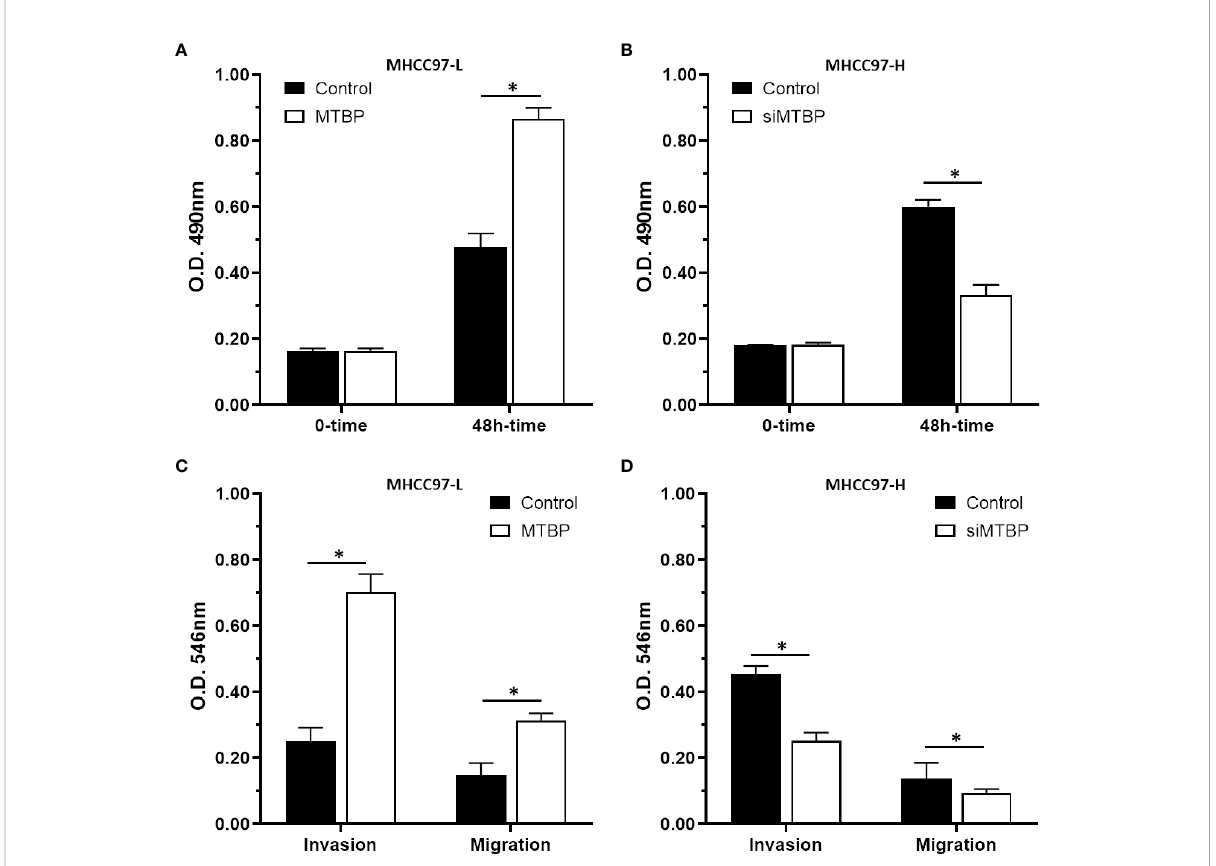
FIGURE 8 MTBP promotes the in vitro proliferation, invasion or migration of HCC cells. (A – C) MHCC97-L cells were transfected with control or MTBP expression vectors, and (B – D) MHCC97-H cells were transfected with control or siMTBP. The cells were analyzed by MTT (A, B) or transwell assays (C, D) . *P <